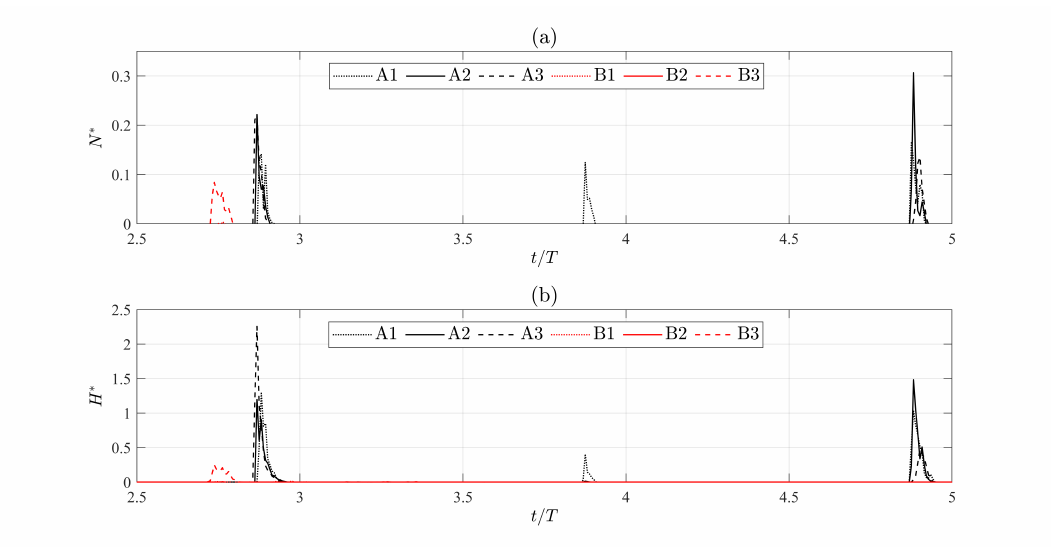
Figure 11. Time history of the normalized pile axial load ( a ) and lateral soil resistance ( b